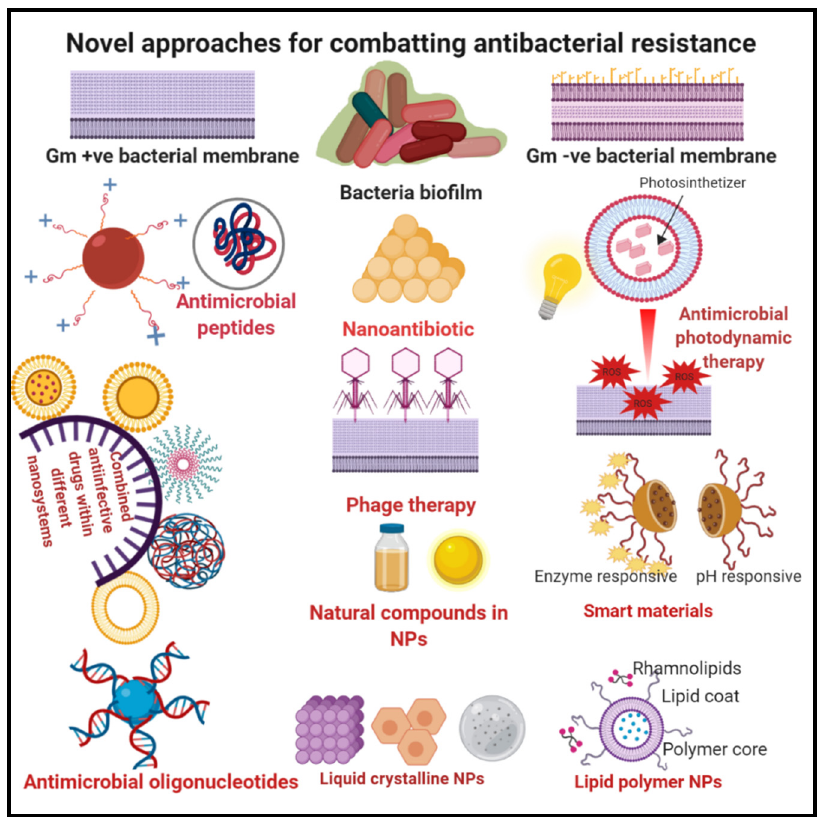
Figure 2. Diagrammatic illustration of the novel approaches utilized for combating antibacterial resistance.